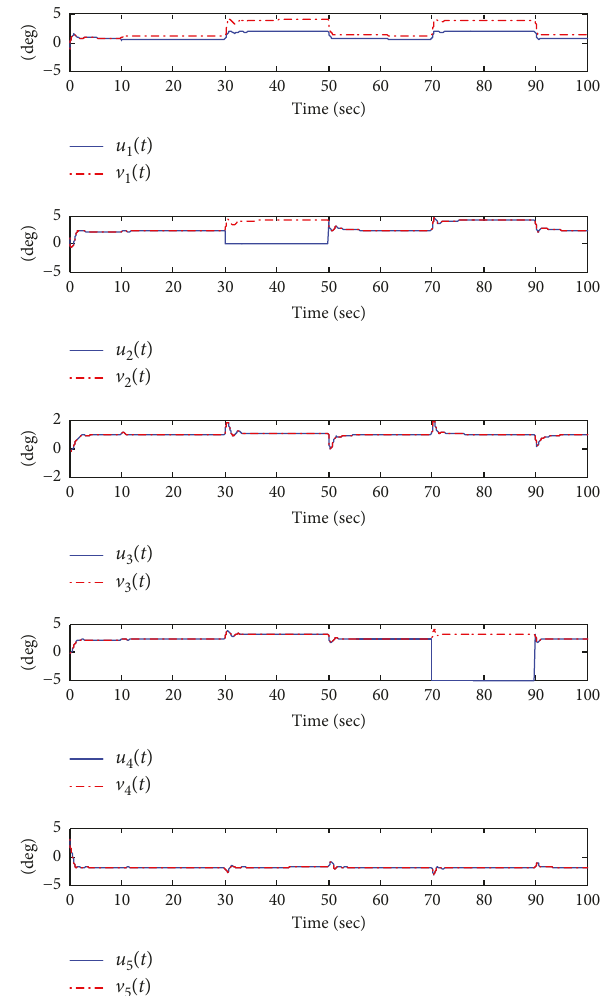
Figure 4: Actual control signal u ( t ) and designed control signal v ( t ) of the controller given in